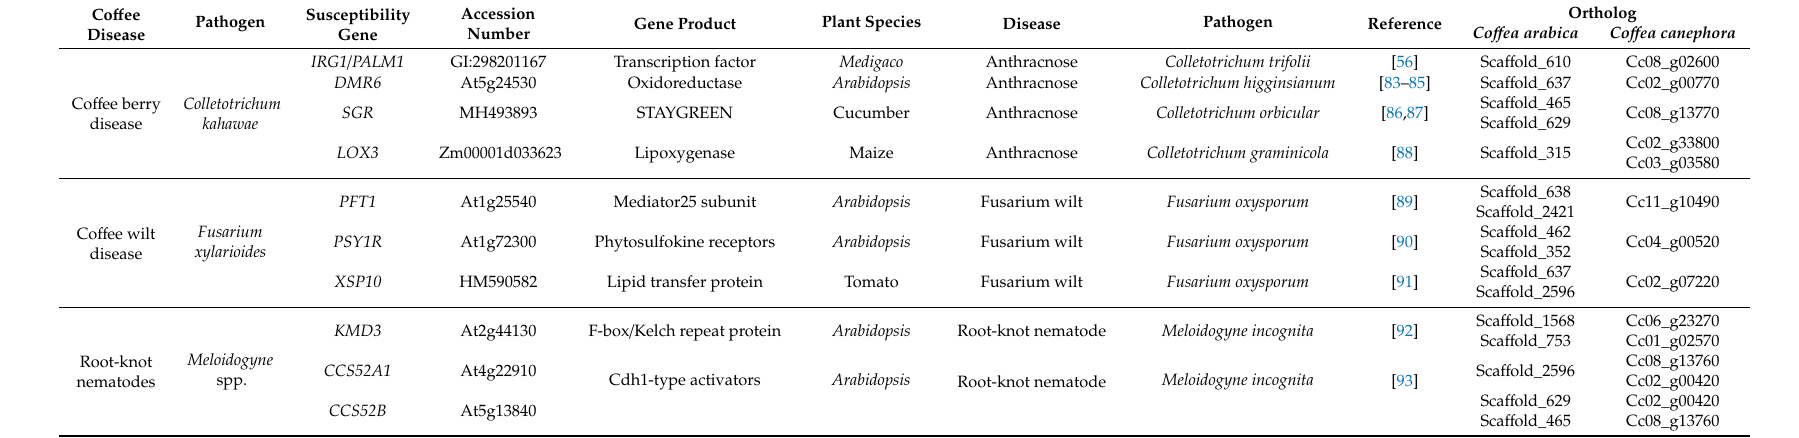
Table 2. Possible susceptibility gene orthologs (according to van Schie and Takken [53]) in Co ff ea